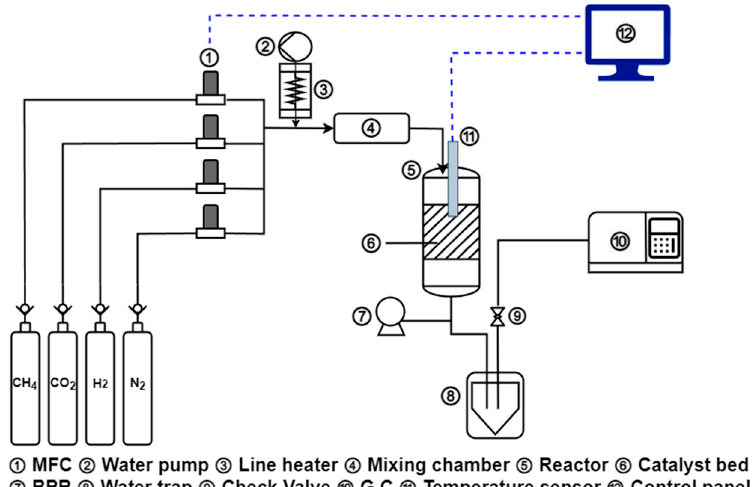
Figure 15. Block diagram of the process for synthesizing the Ni-catalyst used for CO 2 methanation.